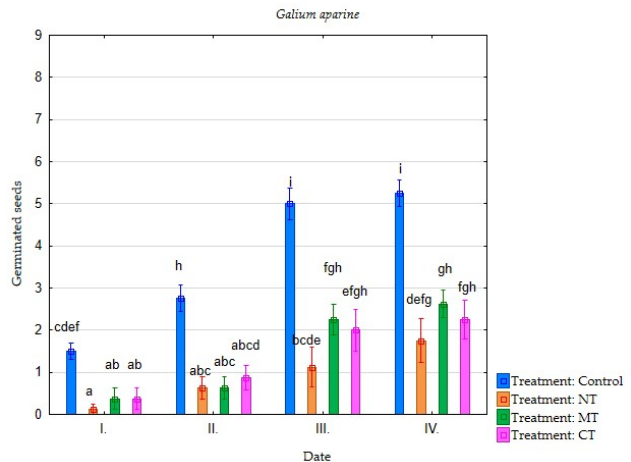
Figure 8. Development of the germination of Galium aparine caryopses watered with soil leachates from different soil tillage. The results represent the mean of 8 biological replicates ± SE. Identical letters express statistical non-significance between the variants, different letters express statistical significance at a significance level p = 0.05 (Fisher LSD test). The plot shows the mean, the whiskers representing the standard error, values with different letter (a, b, c, d, e, f, g, h, i) differ significantly. Variants of tillage technologies: CT—Conventional tillage with ploughing; MT—Minimum tillagethe; NT—Direct sowing.